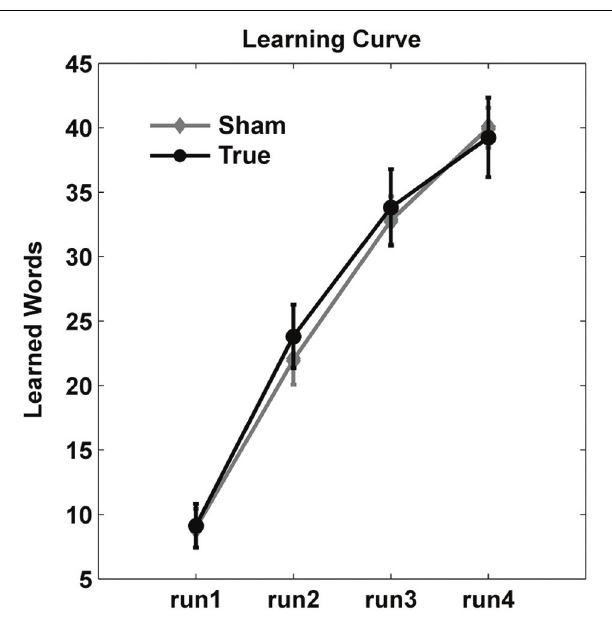
FIGURE 3 | Learning curves. Number of correct responses (mean ± standard deviation) are shown across the four training runs. Overall, cTBS did not enhance training